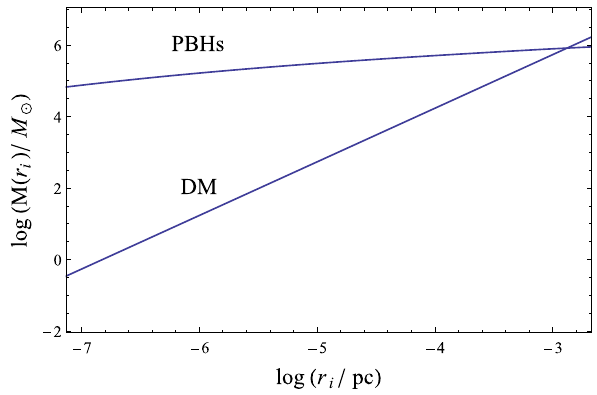
Fig. 4 The initial mass profile M h ( r i ) of the BHs cluster and mass profile M DM ( r i ) of dark matter halo enclosing the cluster. The radius r i isthephysicalradiusoftheshellatthemoment t i ofitshorizoncrossing, therefore the different shells are shown at different moments. That’s the reason the dark matter density does not follow the homogeneous law M DM ∝ r 3 . The parameter values (in GeV): (cid:8) = 5 , f = 1 . 6